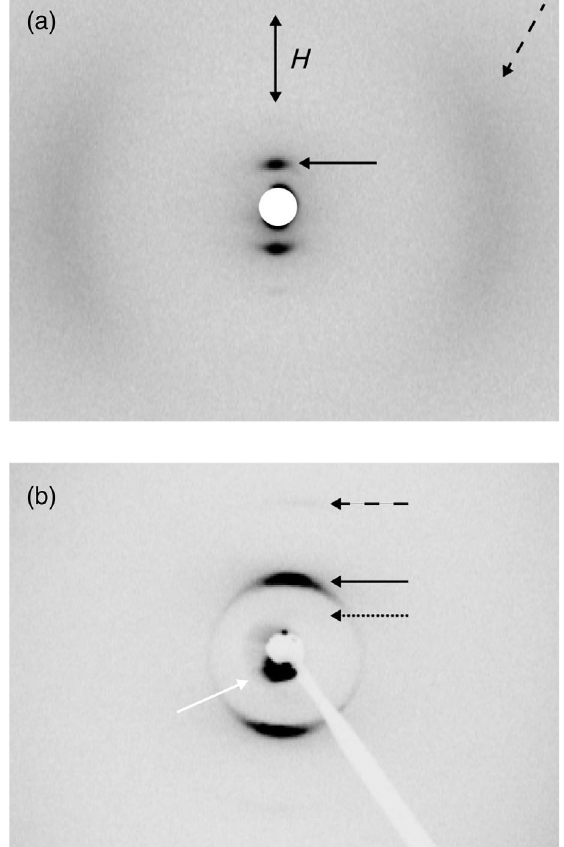
FIG. 2. X-ray scattering patterns of a BP12 sample in the M phase ( T ¼ 97 °C) aligned by a 1.7 T magnetic field H (double- headed arrow). (a) With a 60 mm sample-to-detection distance. The solid arrow points to one of the smectic reflections at small angles, whereas the dashed arrow points at the wide-angle diffuse ring. (The white disk at the center represents the beam stop.) (b) With a 120 mm sample-to-detection distance. The solid arrow points to one of the smectic reflections, the dashed arrow to the barely observable second-order smectic reflection, and the dotted arrow to the absence of any scattering at wave vector q 0 ¼ 2 π =L , where L is the BNA-76 molecular length. (The white arrow points to parasitic scattering around the beam stop.)